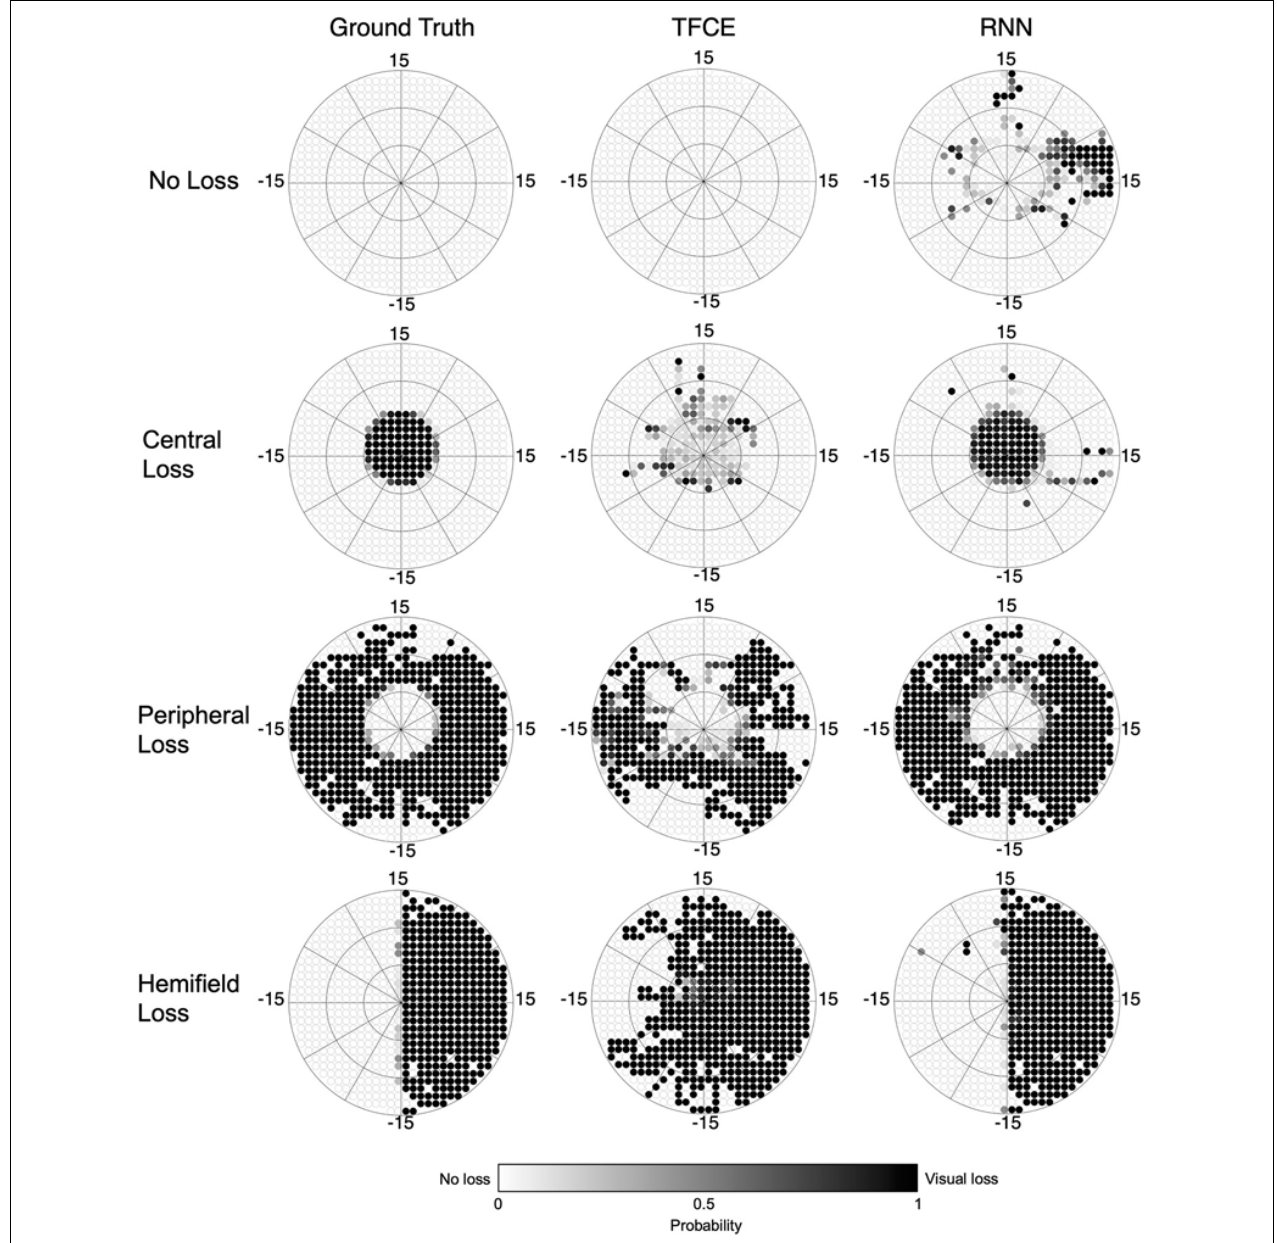
FIGURE 8 | Reconstructed visual field maps for a single participant. Darker color indicates the higher probability of that point being affected by visual loss (white = 0%, black = 100%). The TFCE maps, although less accurate than the RNN ones, still allow the recognition of the shape of the underlying scotomas. The RNN maps, on the other hand, closely resemble the ground-truth